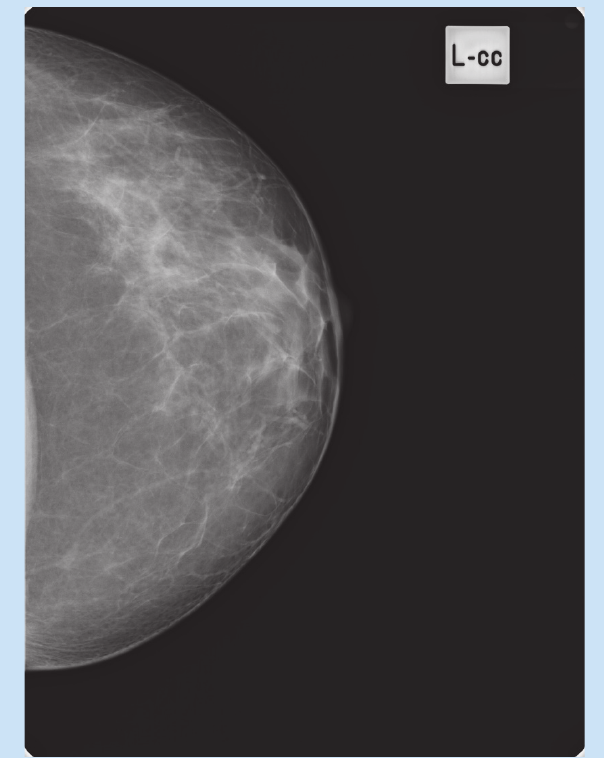
Fig. 1b. Left cranio-caudal